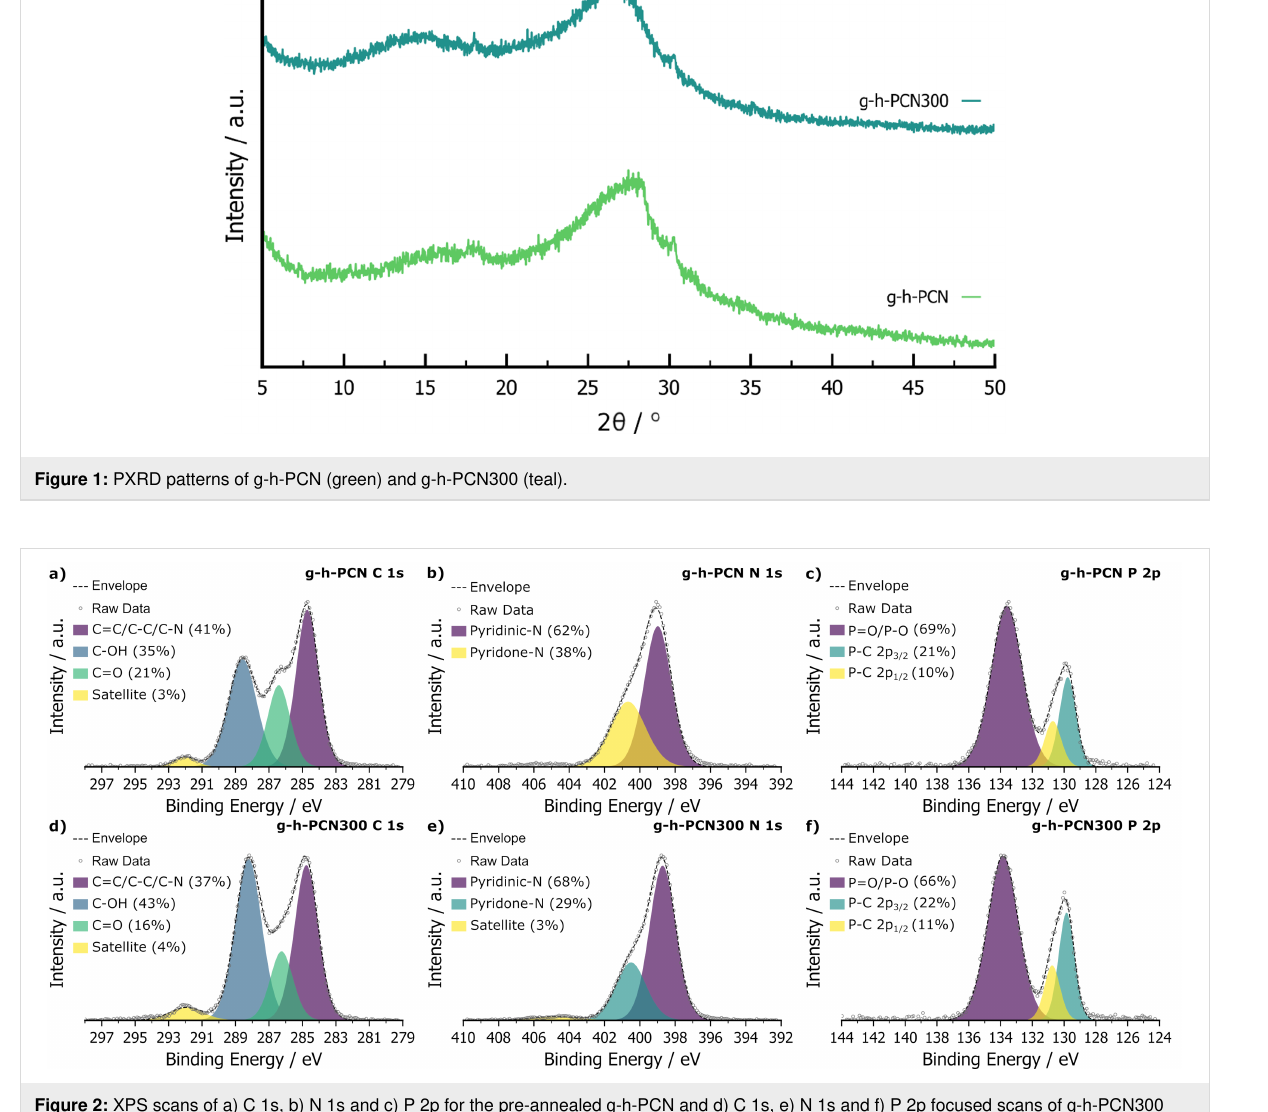
Figure 2: XPS scans of a) C 1s, b) N 1s and c) P 2p for the pre-annealed g-h-PCN and d) C 1s, e) N 1s and f) P 2p focused scans of g-h-PCN300 after annealing at 300 °C for 1